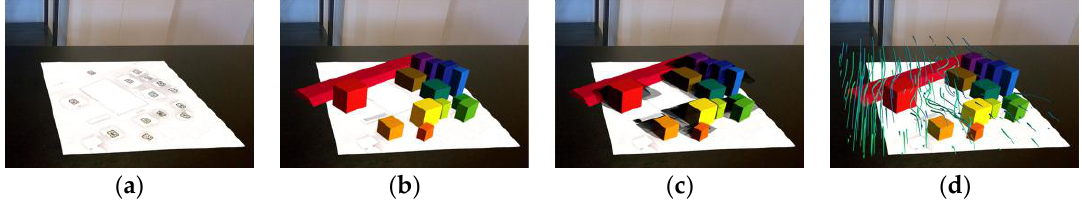
Figure 6. The augmented reality visualization: ( a ) Only the printed masterplan scheme on the table with markers; ( b ) The volumes are overlaid to the print; ( c ) Shadows are displayed; ( d ) Airflow is